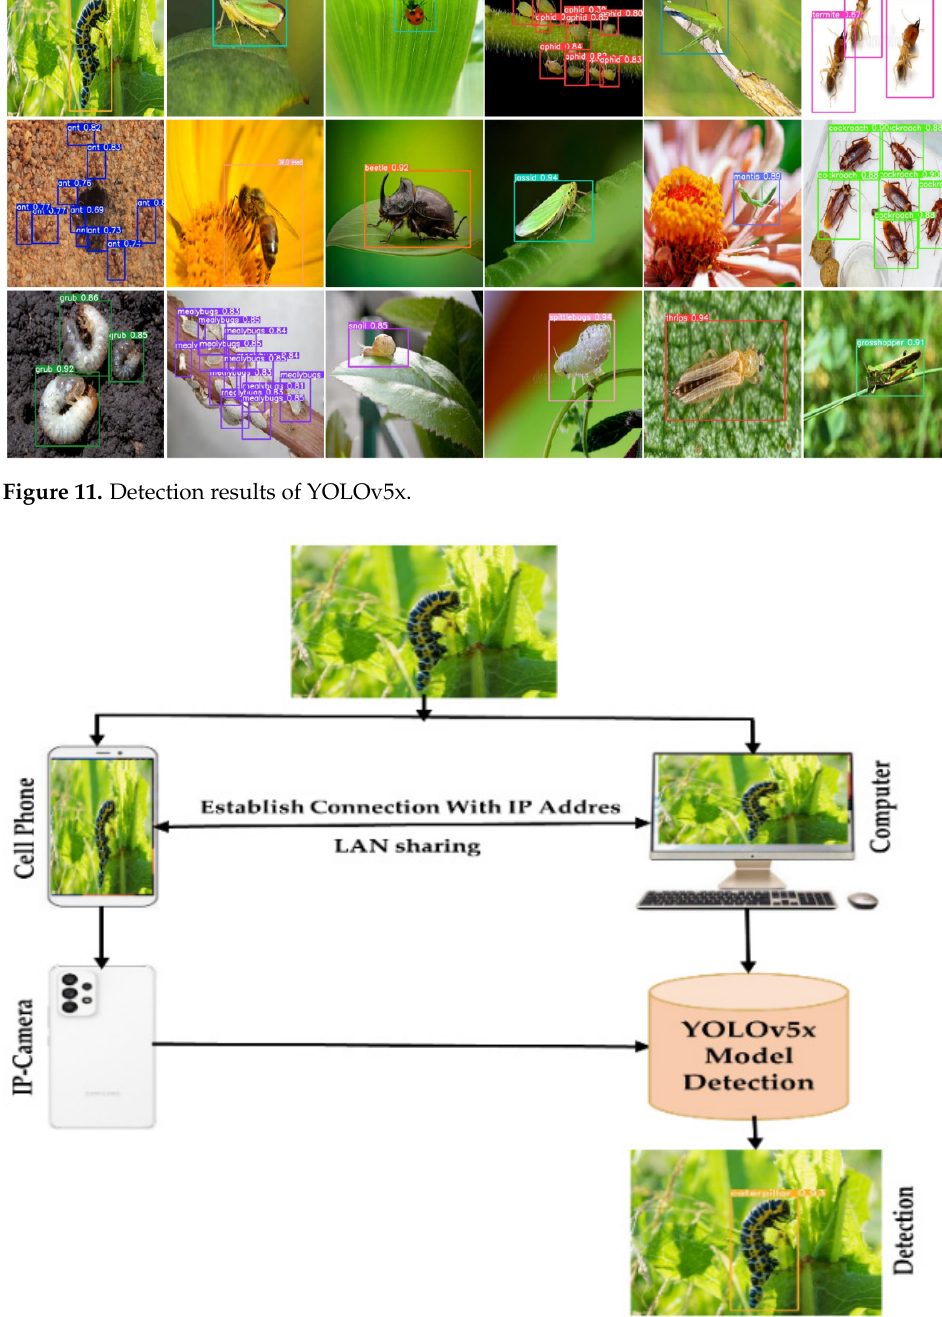
Figure 12. A flowchart of real-time detection on a mobile IP camera.